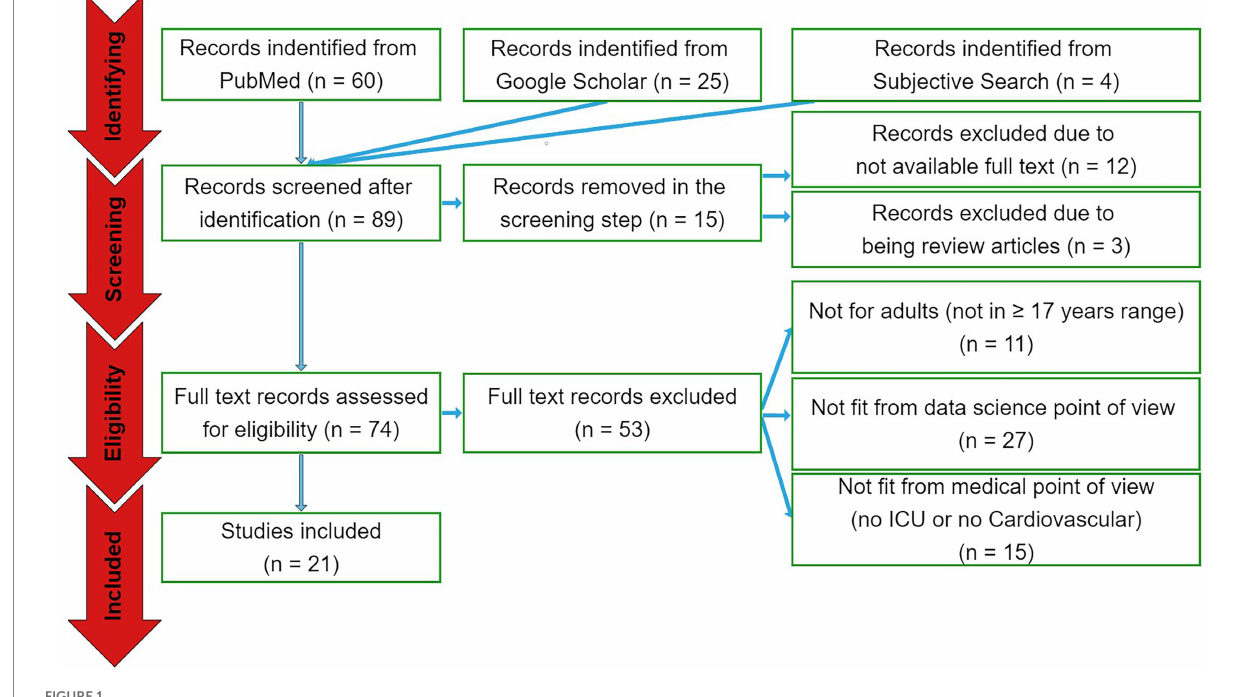
FIGURE 1 The PRISMA diagram. From a total of 89 papers identified by the search queries from the three sources, 15 and 53 papers were excluded in the screening and eligibility assessment phases, respectively. Accordingly, 21 papers were included to be